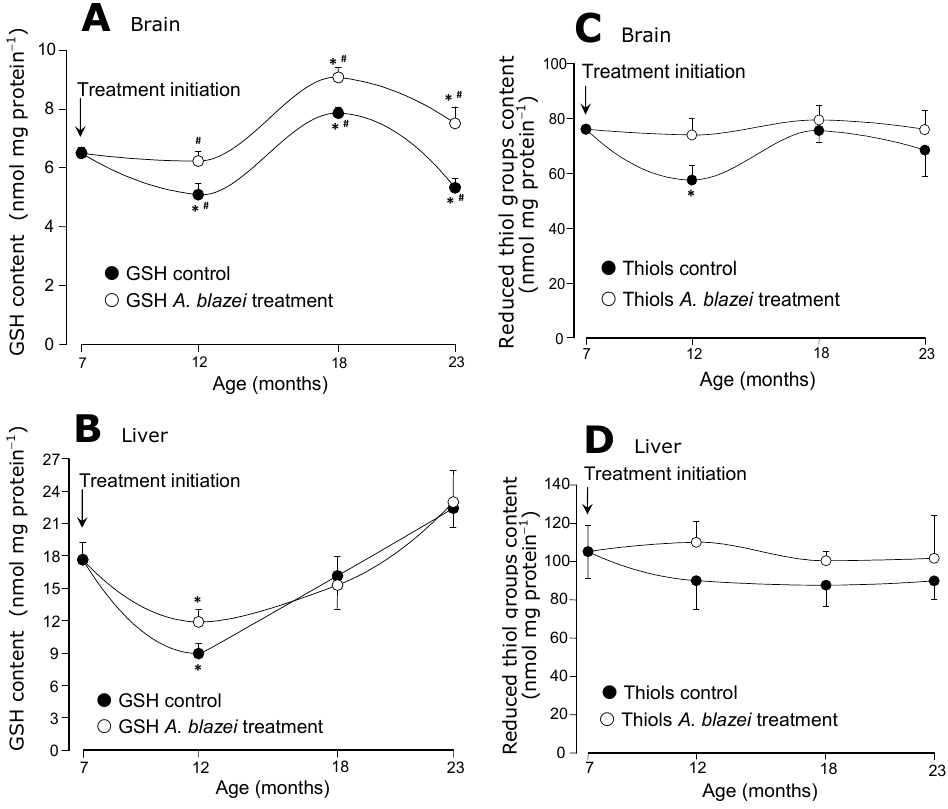
Figure 3. ( A ) Reduced glutathione (GSH) levels of brain homogenates. ( B ) Reduced glutathione (GSH) levels of the liver homogenates. ( C ) Protein thiol groups of the brain homogenates. ( D ) Protein thiol groups of the brain homogenates. The data points represent the means ± mean standard errors of five to seven animals. The statistical analysis consisted of MANOVA followed by Duncan’s multiple range post hoc testing. Data points labeled with asterisks (*) are values significantly different ( p ≤ 0.05) from those found at 7 months (treatment initiation). Statistically different pairs of values for a given age are labeled with hashes